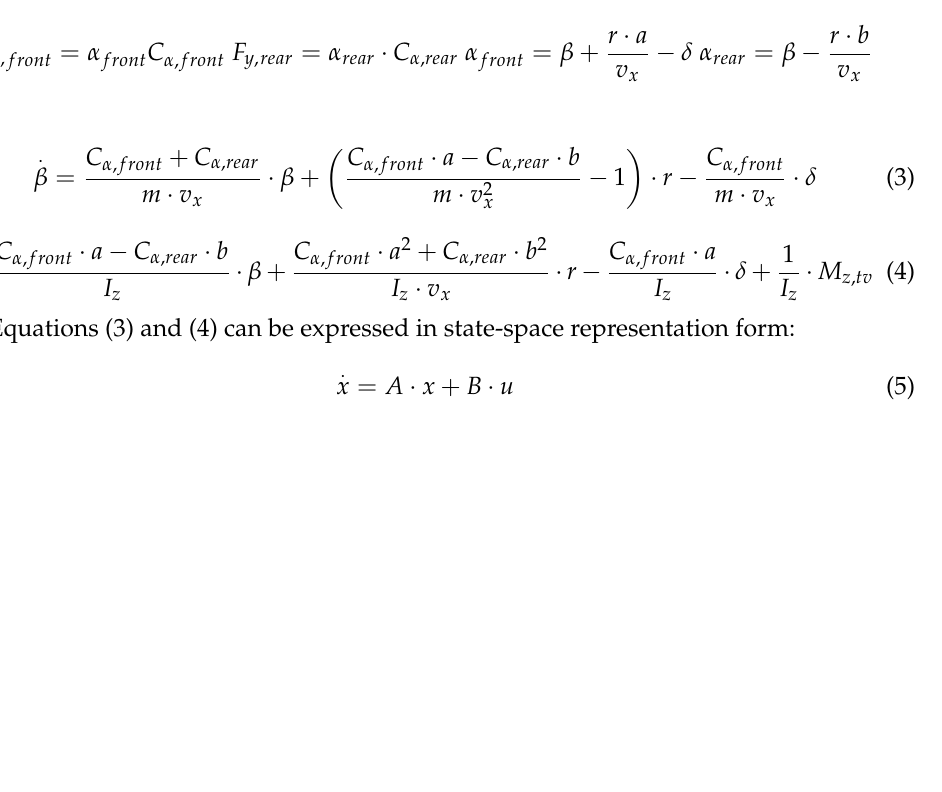
Assuming linear tyres around the operating point and their respective cornering stiffnesses C α ,front and C α ,rear and relating front and rear slip angles α front and α rear to vehicle sideslip angle β , yaw rate r , and front-wheel steer angle δ , we have: